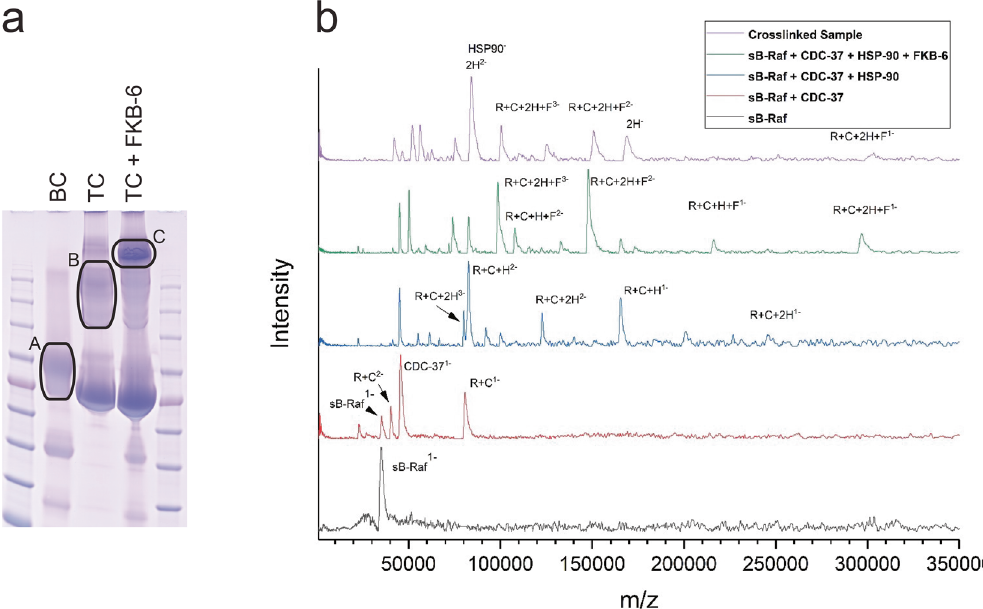
Figure 5. Stoichiometry of Raf-complex formation. (a) Impact of single components by crosslinking on the complex formation. BC = sB-Raf with CDC-37; TC = BC with the addition of HSP-90 dimer. The labeled gel area is used in later MS analysis. (b) Native MS of crosslinked sample from (c) vs single components, R = sB-Raf; C = CDC-37; D = HSP-90; F = FKB-6.